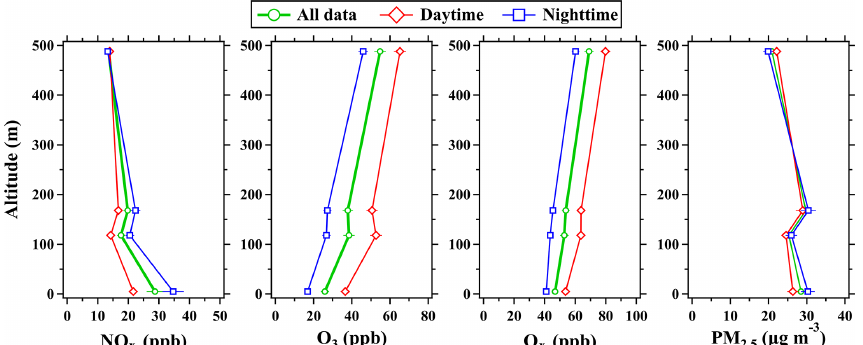
Figure 10. Average vertical profiles of O 3 , NO x , O x (O 3 + NO 2 ), and PM 2 . 5 concentrations (mean ± 0.1SDs) measured at the four CTT sites (5, 118, 168, 488m) during the campaign. Daytime refers to the time between 08:00–18:00LT; nighttime refers to the time between